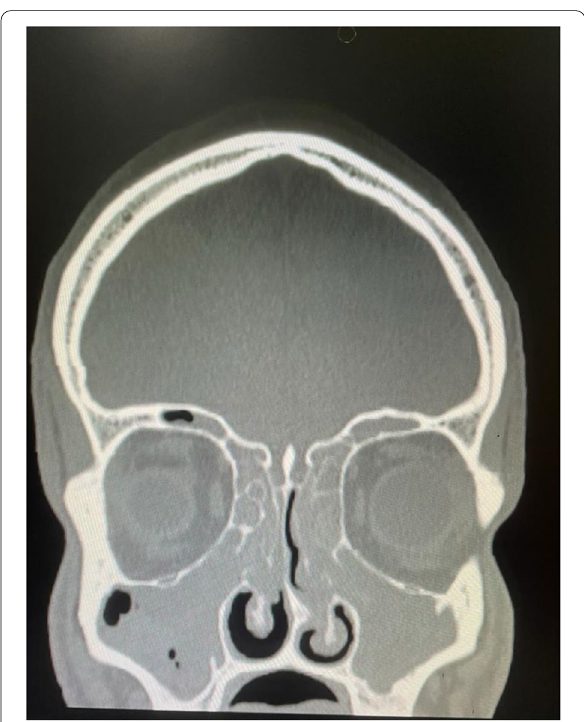
Fig. 2 Showing Keros variation type 3 bilaterally